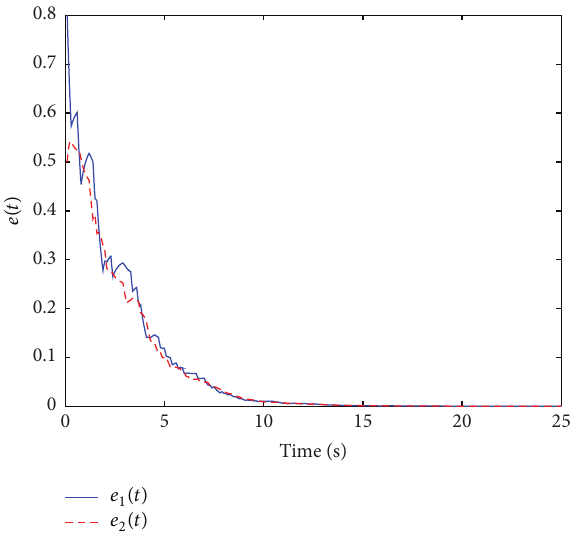
Figure 6: The curve of error 𝑒(𝑡) by mode-independent